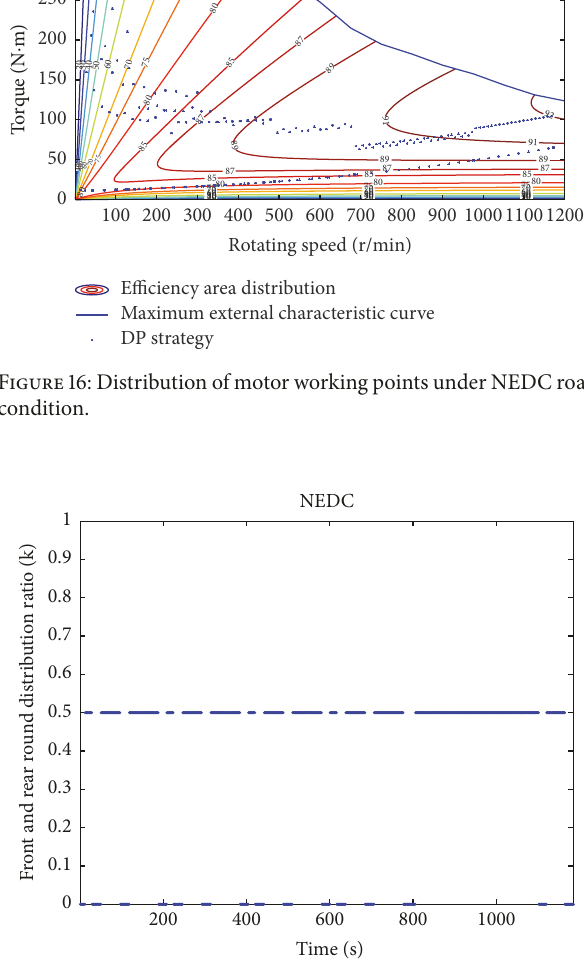
Figure 17: Torque distribution factor diagram.